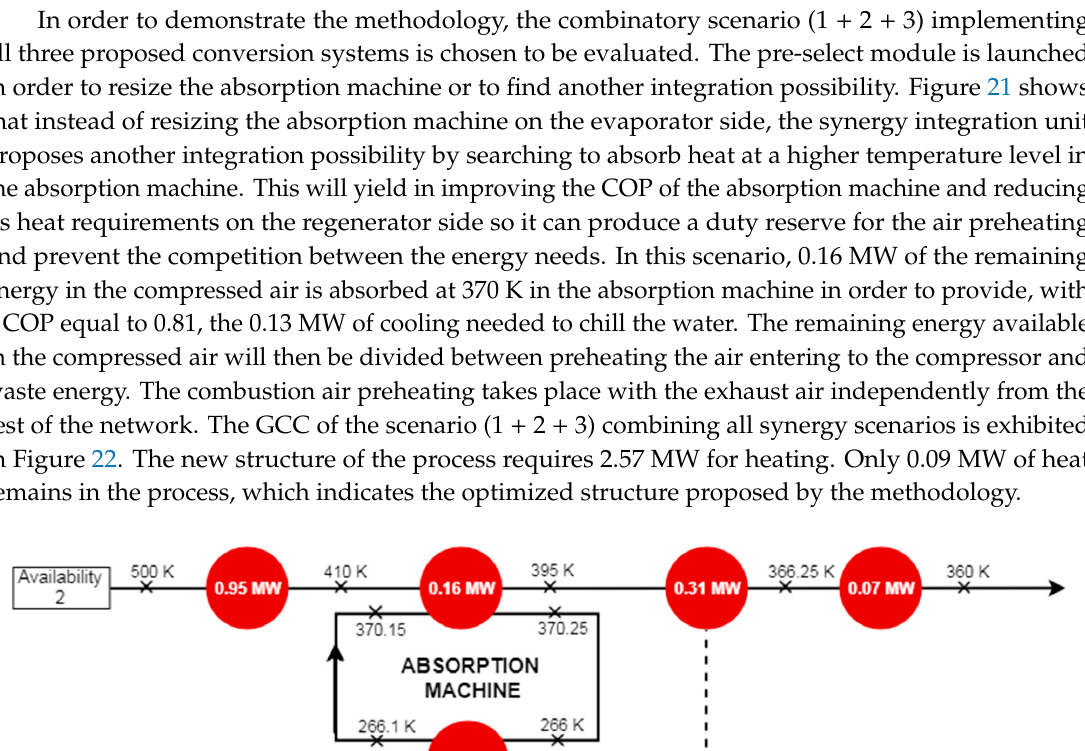
Figure 22. GCC of scenario (1 + 2 + 3). Figures 23 and 24 represent, on different y-axis scales, the ED distribution in the process’ unitary operations and the total ED for the considered scenarios. The initial ED is decreasing in each of the single-scenarios and in the combinatory scenario. Interpreting the diagram allows concluding that in the scenarios exploiting the heat in the compressed after E1; the ED in exchanger HX4 is reduced caused by the load reduction of the exergy rejected. However, only in scenario 3 the recovery in E1 is increased because of the rise of the cold stream inlet temperature, which is reflected by an increase in the ED of the recovery exchanger E1 versus a consequential decrease in the ED of HX1 where utility heating is required. In this scenario, it is also noticeable that even though the work of the compressor is increased, the local ED in C1 is increasing very slightly. In fact, the ED increase because of the supplementary work consumption, is largely compensated by the decrease in the flow exergy caused